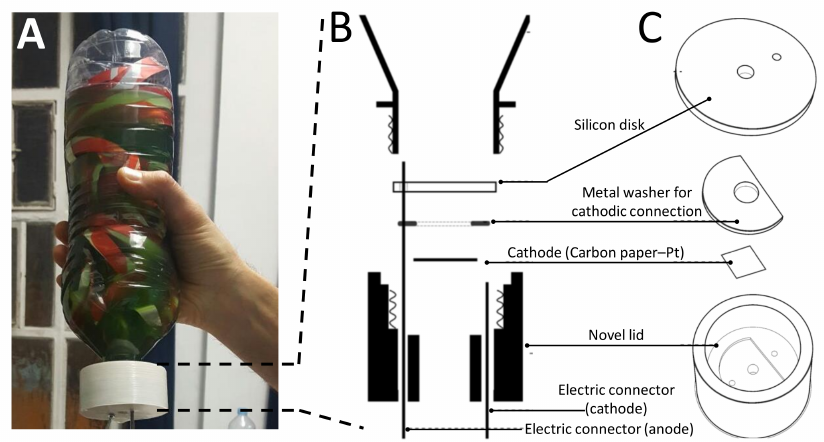
Figure 1. The Bio-Bottle-Voltaic (BBV) system. ( A ) The actual BBV system. ( B ) Schematic cross section of the components forming the lid of the BBV system. ( C ) A 3D semi-exploded view of the components forming the lid of the BBV